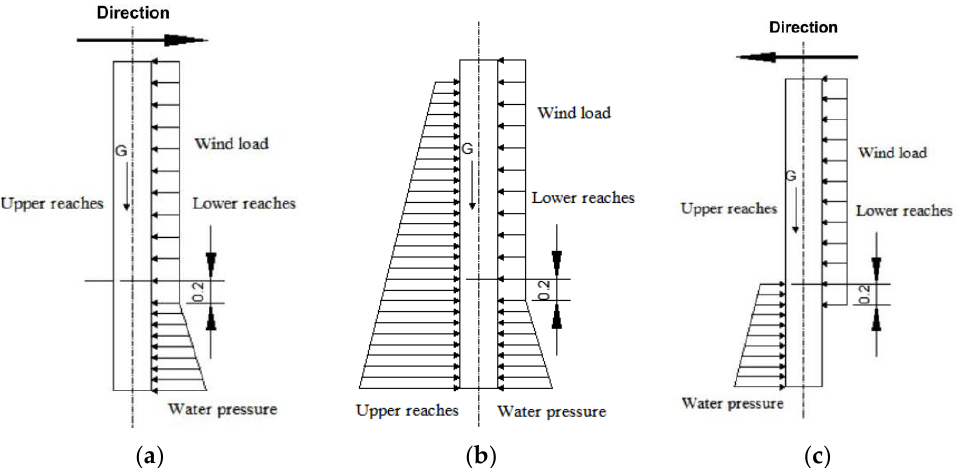
Figure 5. Schematic diagram of the force under the operation of the herringbone door under differ- ent working conditions: ( a ) closed condition, ( b ) filling water condition, ( c ) opening